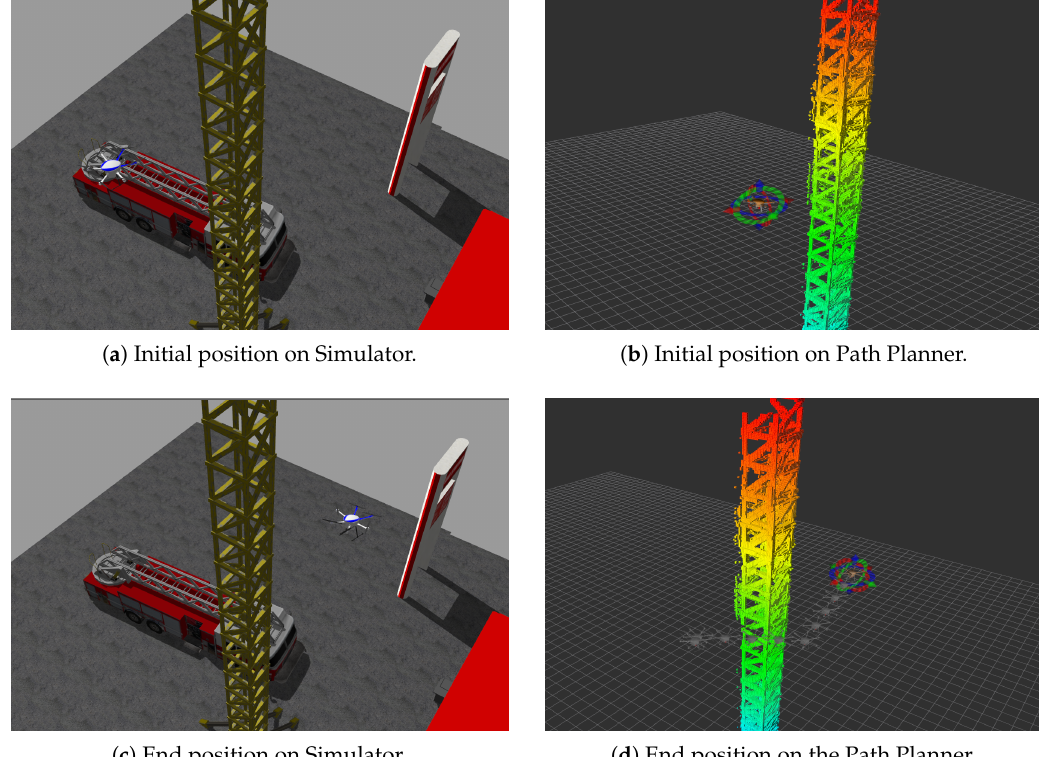
Figure 3. Hexacopter navigation on a simulated environments with Static Collision Avoidance awareness, using Framework for Fully Autonomous UAVs